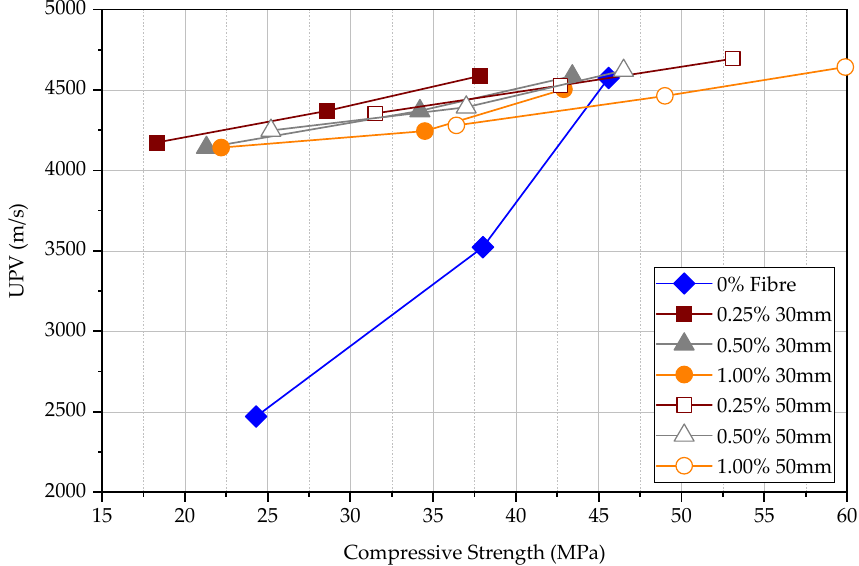
Figure 13. Direct UPV measurements vs compression strength.